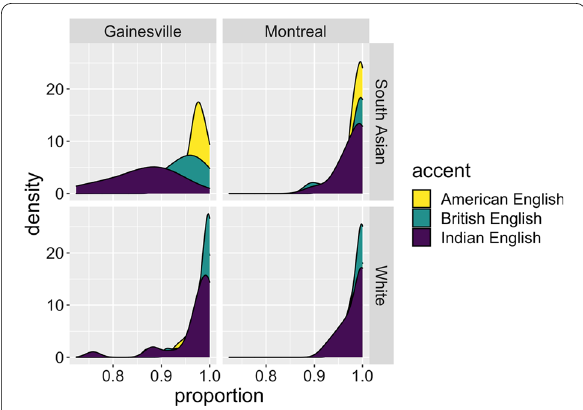
Fig. 4 Proportions of intelligibility scores in Montreal and in Gainesville for each face and